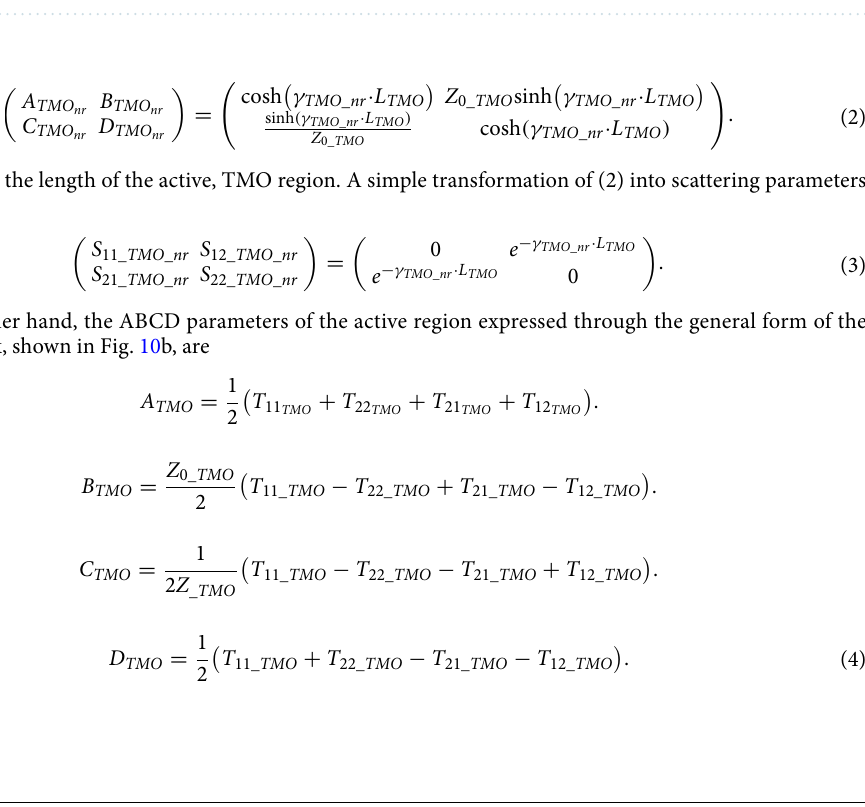
Figure 7. DC cycling of 5 mm long active regions; ( a ) NiO and ( b ) TiO 2 : (blue circles) cycling up and (red squares) cycling down (showing